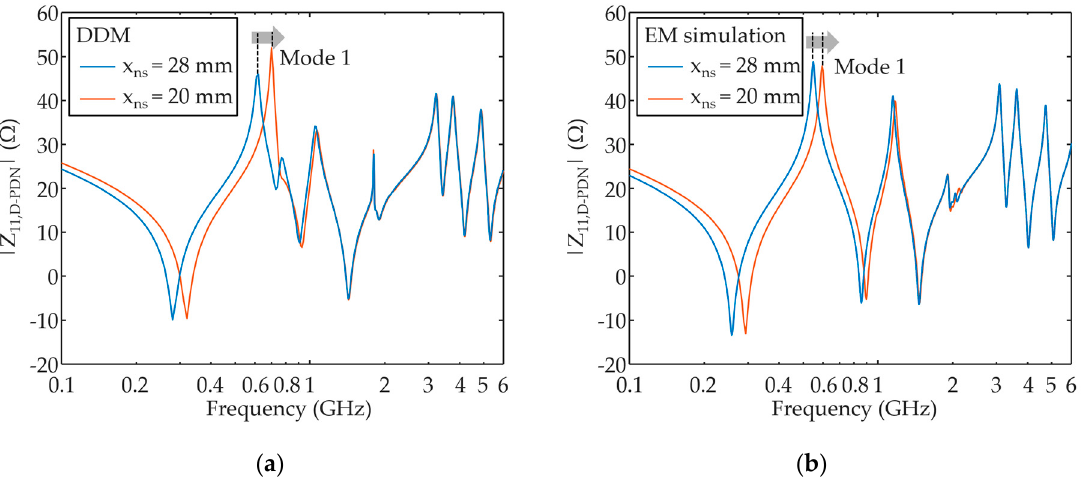
Figure 14. Comparison of self-impedances of different size PDNs from ( a ) DDM and ( b ) electromagnetic (EM) simulation.